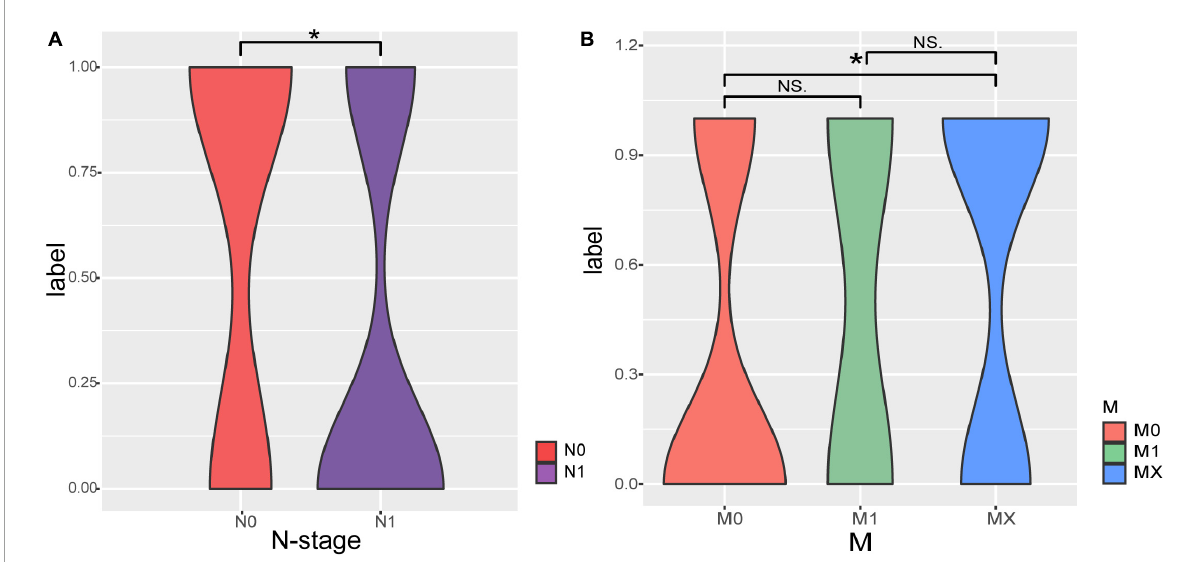
FIGURE1 The correlations of Tumor Node Metastasis classification (TNM) stage with recurrence and metastasis. (A) Patients with recurrence or metastasis are accompanied by increased lymph node involvement. (B) Comparisons of M staging in patients with RM and no-RM; Wilcoxon test is used to compare between different groups of samples. The X -axis represents the different stages of patients; Y -axis represents the recurrence and metastasis, 0: recurrence or metastasis; 1: without recurrence and